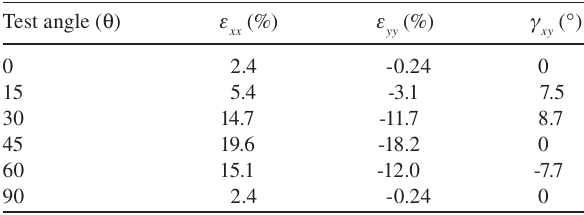
Table 2 Failure strain components for woven E-glass vinyl